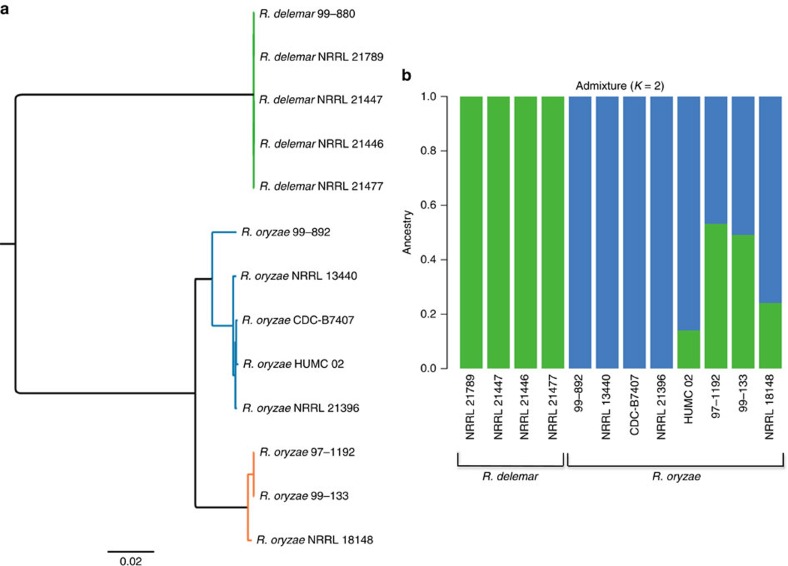
Population structure of R. oryzae and R. delemar strains.(a) SNP-based whole-genome maximum-likelihood phylogeny of all 13 R. delemar and R. oryzae strains. All nodes have a bootstrap value of ≥97 out of 100. (b) Population structure inferred using the program Admixture. Values represent fraction of population ancestry denoted by colours: green (R. delemar) and blue (R. oryzae).